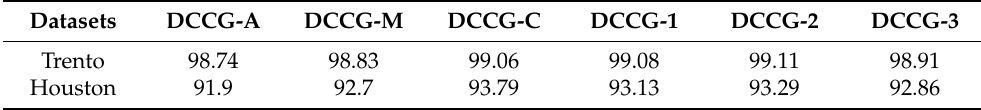
Table 5. Effect of different fusion strategies on OA (%).